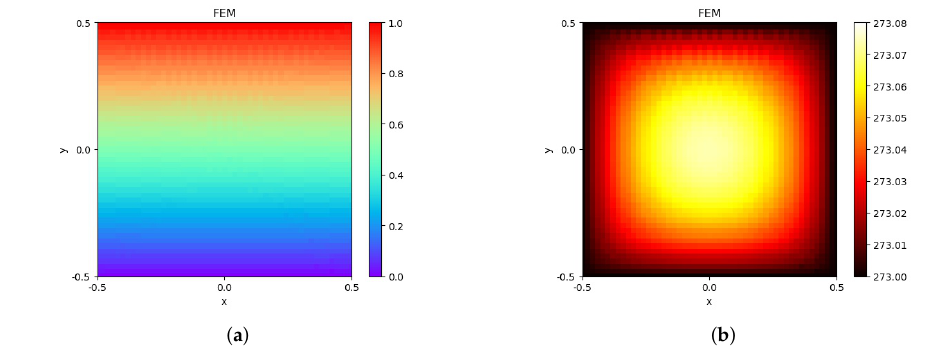
Figure 6. Result of the FEM: ( a ) the electric potential (V); ( b ) the temperature